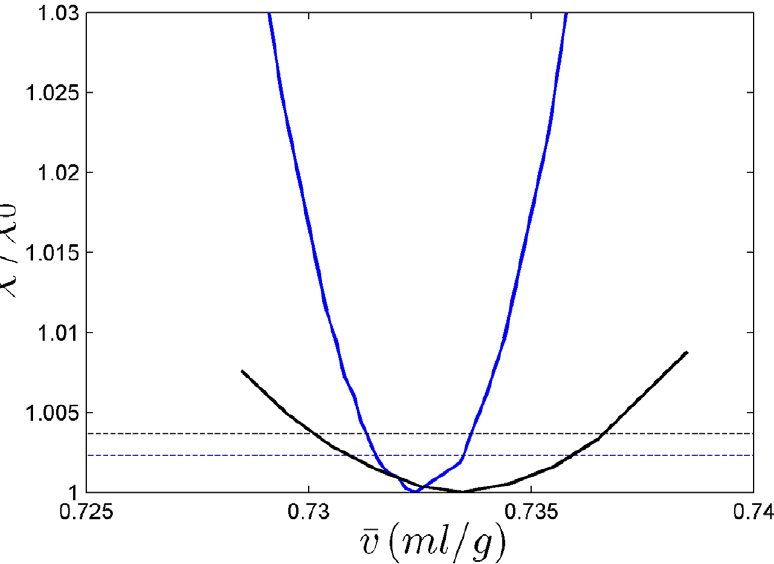
Figure 9. Projections of the error surface as a function of (cid:2) vv -values. Shown are the relative increase in the x 2 of the fit as a function of different fixed (cid:2) vv -values, for each value freely adjusting all other unknown parameters [79]. Data are shown for the absorbance IgG data set (black) and the interference data set from the BSA sample (blue). For each, the dashed line shows the increase predicted by F-statistics for the 68% confidence level [79]. This critical increase of x 2 is lower for the BSA data set due to the significantly larger number of data